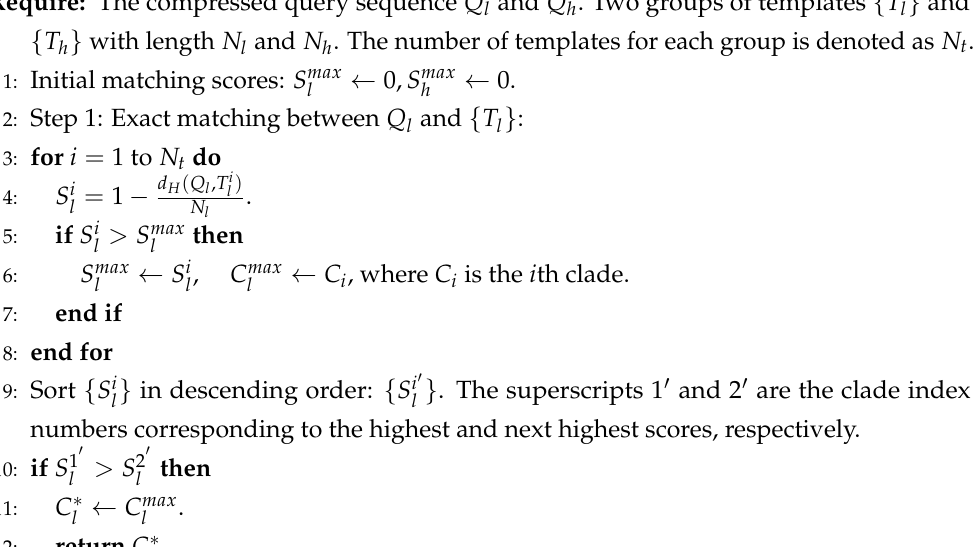
Algorithm 1 Two-level resolution template matching